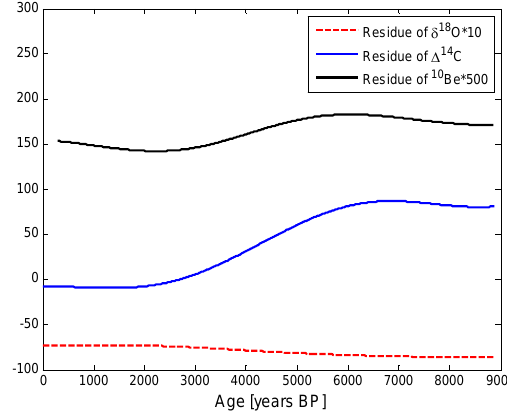
Fig.5 Fig. 5. Residues of δ 18 O (a) , 1 14 C (b) and 10 Be (c)